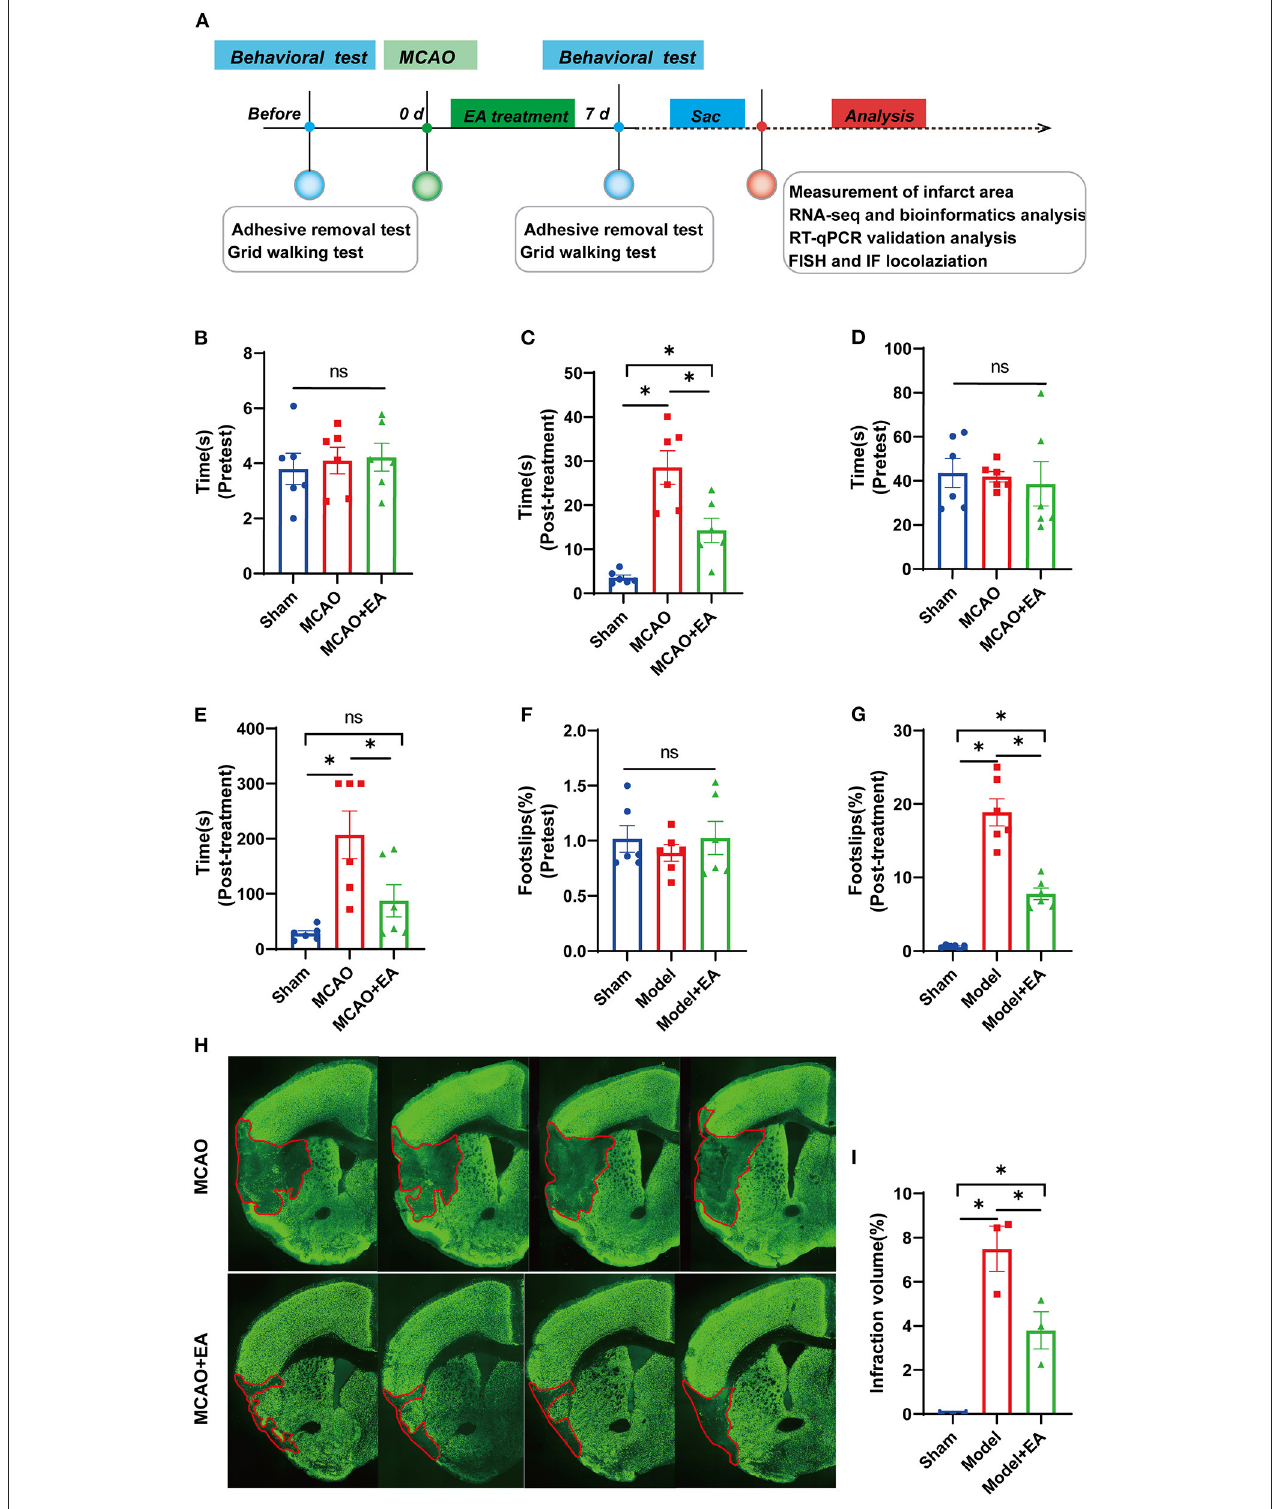
FIGURE 1 | Electroacupuncture (EA) alleviates neurological deficits of middle cerebral artery occlusion (MCAO) mice. (A) A timeline schedule of the experimental protocol. (B) The time taken for the mice to notice the stickers on their forepaws among the three groups before MCAO surgery ( n = 6 mice/group). (C) The